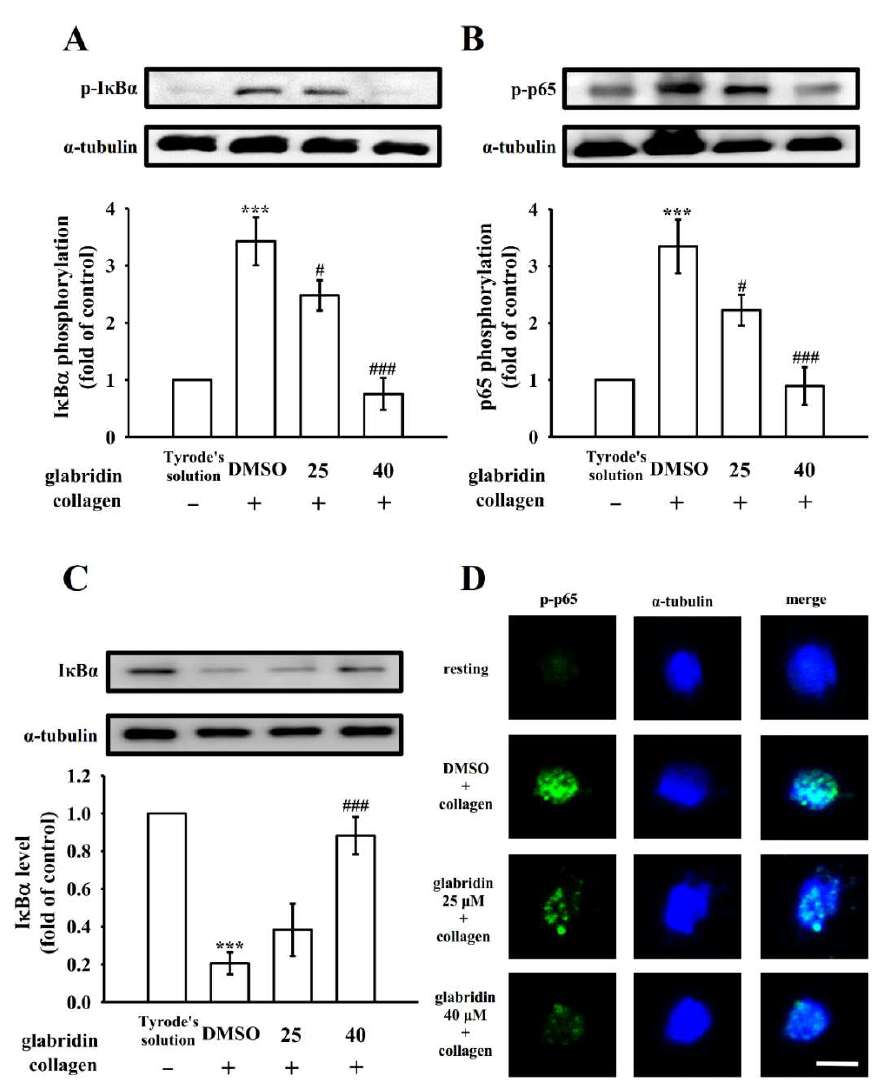
Figure 5. Effects of glabridin on the activation of NF-κB in human platelets. Washed platelets were preincubated with DMSO (0.1%) or glabridin (25 and 40 μM) and then treated with collagen (1 μg/mL) for the immunoblotting of ( A ) IκBα and ( B ) p65 phosphorylation, or ( C ) IκBα degradation, and confocal microscopic assessment (1000× magnification) of ( D ) phosphorylated NF-κB (p65) (green fluorescence) and α-tubulin (blue fluorescence) using goat anti-rabbit CF TM 488A and anti- mouse CF TM 405M dyes, respectively. Data are expressed as the mean ± standard error of the mean (n = 4). *** p < 0.001 vs. resting platelets (in Tyrode’s solution); # p < 0.05 and ### p < 0.001 vs. 0.1% DMSO + collagen group. The confocal images represent four independent experiments. Bar: 2.5 μm.